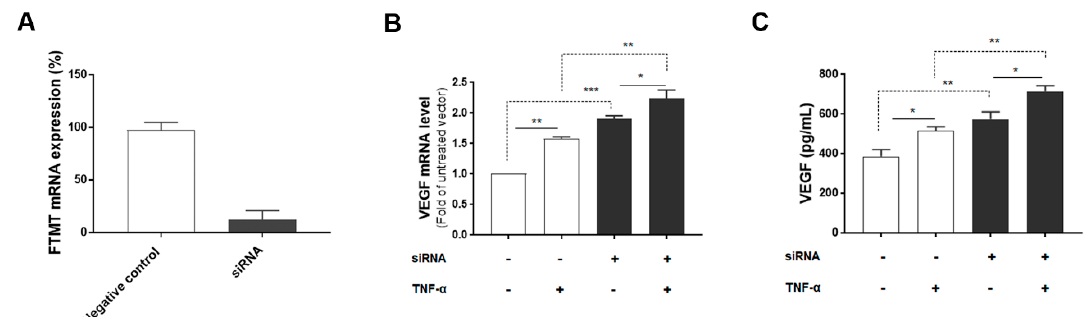
Figure 4. VEGF expression in FTMT gene-silenced ARPE-19 cells: ( A ) Effective silencing of the FTMT gene in ARPE-19 cells. Quantification of FTMT mRNA levels compared with the negative control group 48 h after FTMT siRNA transfection. Data were analyzed by t-test. ( B ) The qPCR results showing the amount of VEGF mRNA in FTMT silenced cells. The relative expression of mRNA was normalized by the ACTB gene. ( C ) Secreted VEGF in the conditioned media was measured using ELISA. Data for Figure 4B,C were analyzed by one-way ANOVA with the Sidak’s test (* p < 0.05 and ** p < 0.01, *** p < 0.001, n = 4). Results are shown as the mean ± SEM.